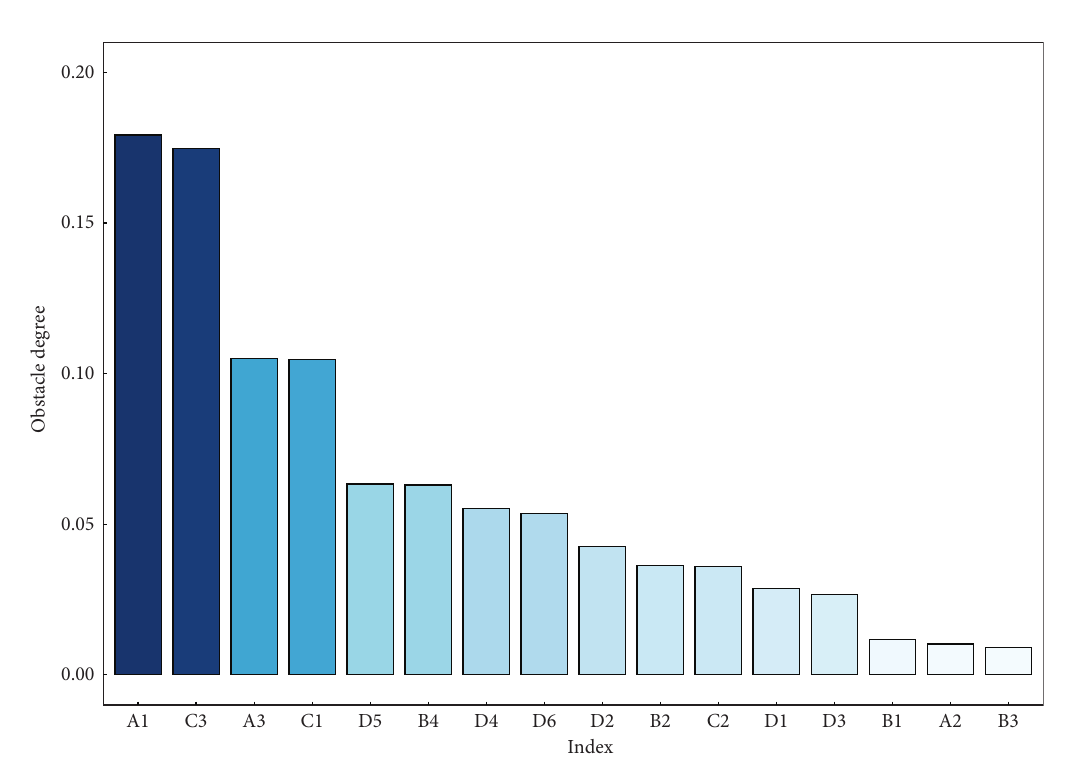
Figure 4: Obstacle degree of indicators for the development of higher education in